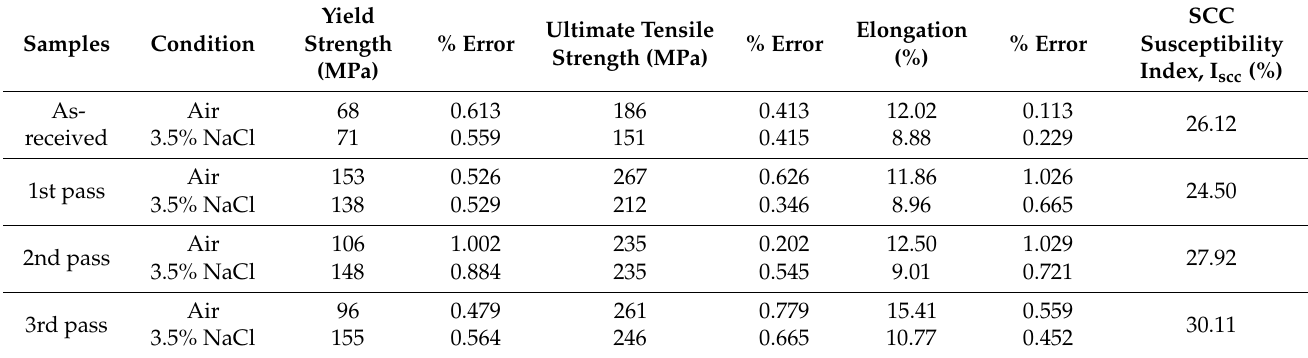
Figure 5. Comparison of stress–strain values of the samples tested in 3.5% NaCl solution with different passes. Table 2. Yield strength, UTS, elongation, and stress corrosion cracking (SCC) values of as-received and ECAP Al5083 alloy samples.